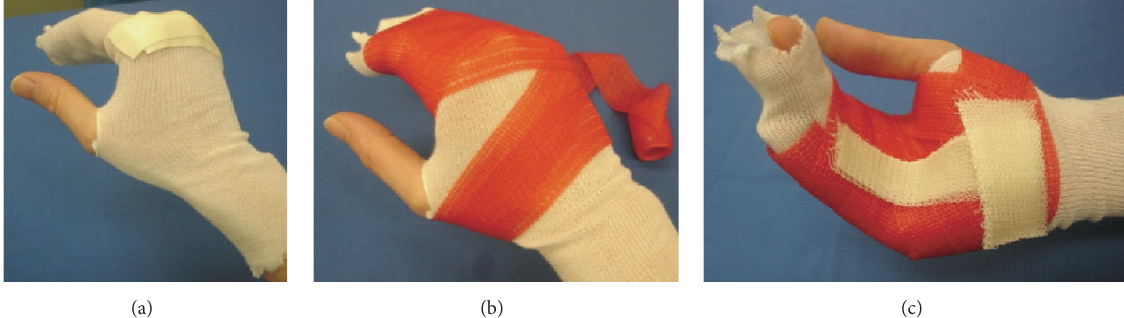
Figure 1: Application of custom-made orthoses. (a) Basic cushioning with tube-gauze and Microfoam ™-tape; function: (i) cushioning and (ii) absorption of skin moisture. (b) Circular application of semirigid cast role (red: Soft-Cast™, width 2.5–5 cm). No more than two to four layers of the material are necessary. (c) Integration of rigid cast stripes (white: Primacast™). There is sufficient time to bring each joint and finger in the desired functional position. Note: hardening through polymerization is strongly accelerated ( < 3 min) by the application of water via a moist bandage. A final trim of semirigid cast material (in contrast to rigid cast material) can be easily performed after hardening. If out-of-cast physiotherapy is desired, the orthoses can be cut open dorsally and self-adhesive Velcro™-tape applied to refitting as seen in Figure 2. Note: disposable rubber gloves should be worn to avoid chronic exposure to solvent in the synthetic cast